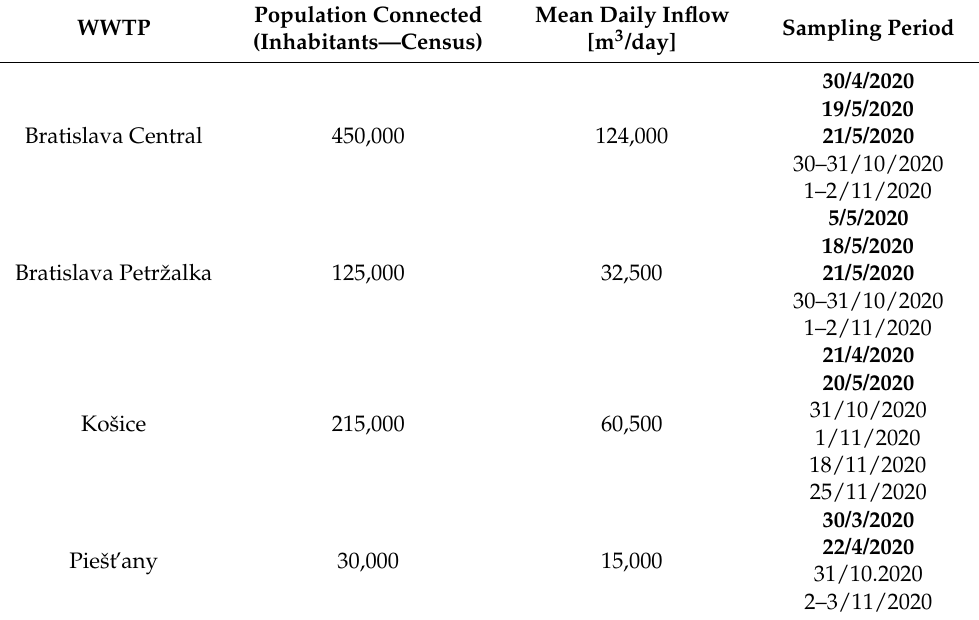
Table 1. Characteristics of selected WWTPs and sampling period. Population Connected WWTP (Inhabitants—Census)